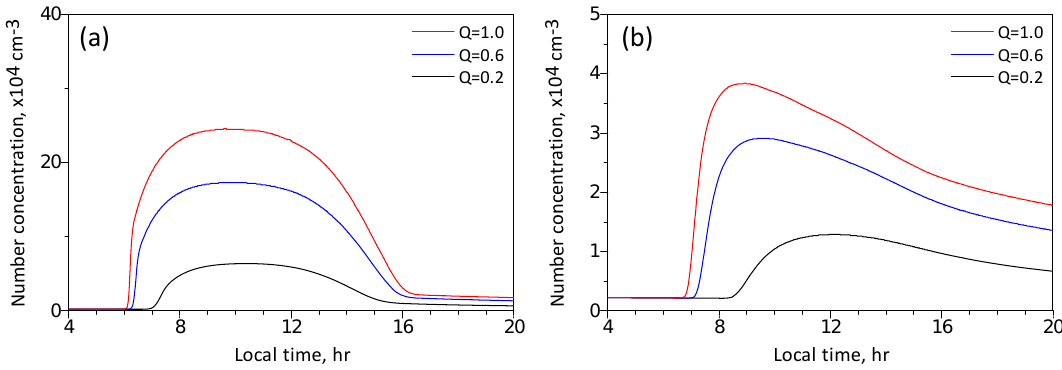
Fig. 4. Simulated diurnal evolution of aerosol number concentration for the conditions of Shimen with different actinic flux transmission ratios. (a) All particles ( D -all); (b) Particles with diameter greater than 10nm ( D >